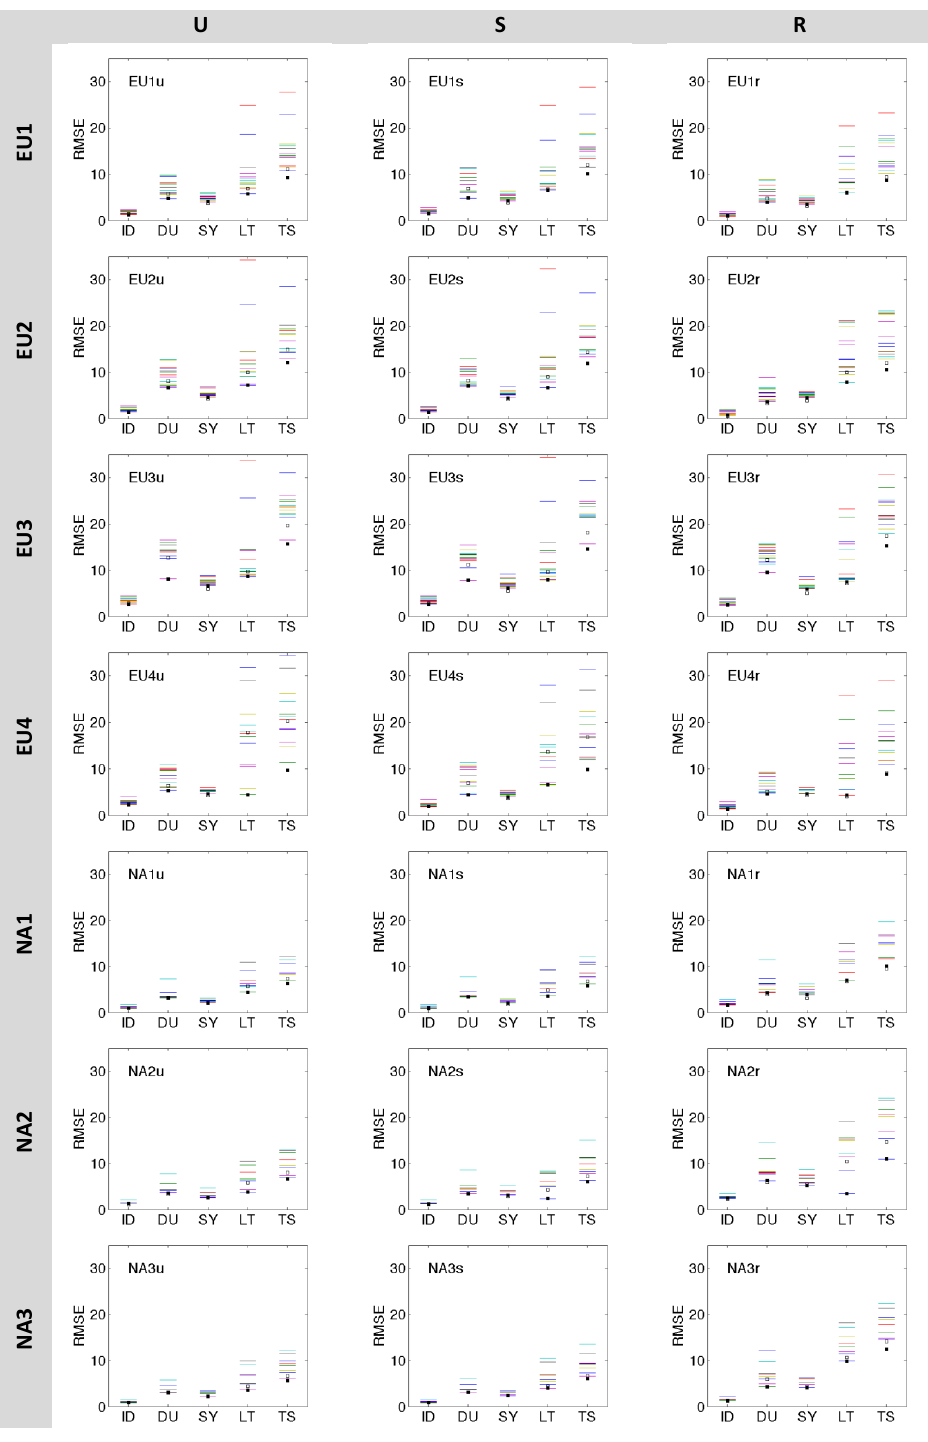
Fig. 7c. Properties of the spectrally decomposed modelled time-series of ozone, into four (ID, DU, SY, LT) components, versus their observed counterparts. Results are shown for all seven subdomains and three ozone aggregation types. For all plots, the square marker reflects the mm, the filled square the kz, the red circle the observations and the coloured lines the individual models. (c) RMSE: spectral RMSE for all ensemble members and total time series RMSE (TS). Building a model from different spectral components (filled square) results in lower RMSE than the documented ensemble mean (unfilled